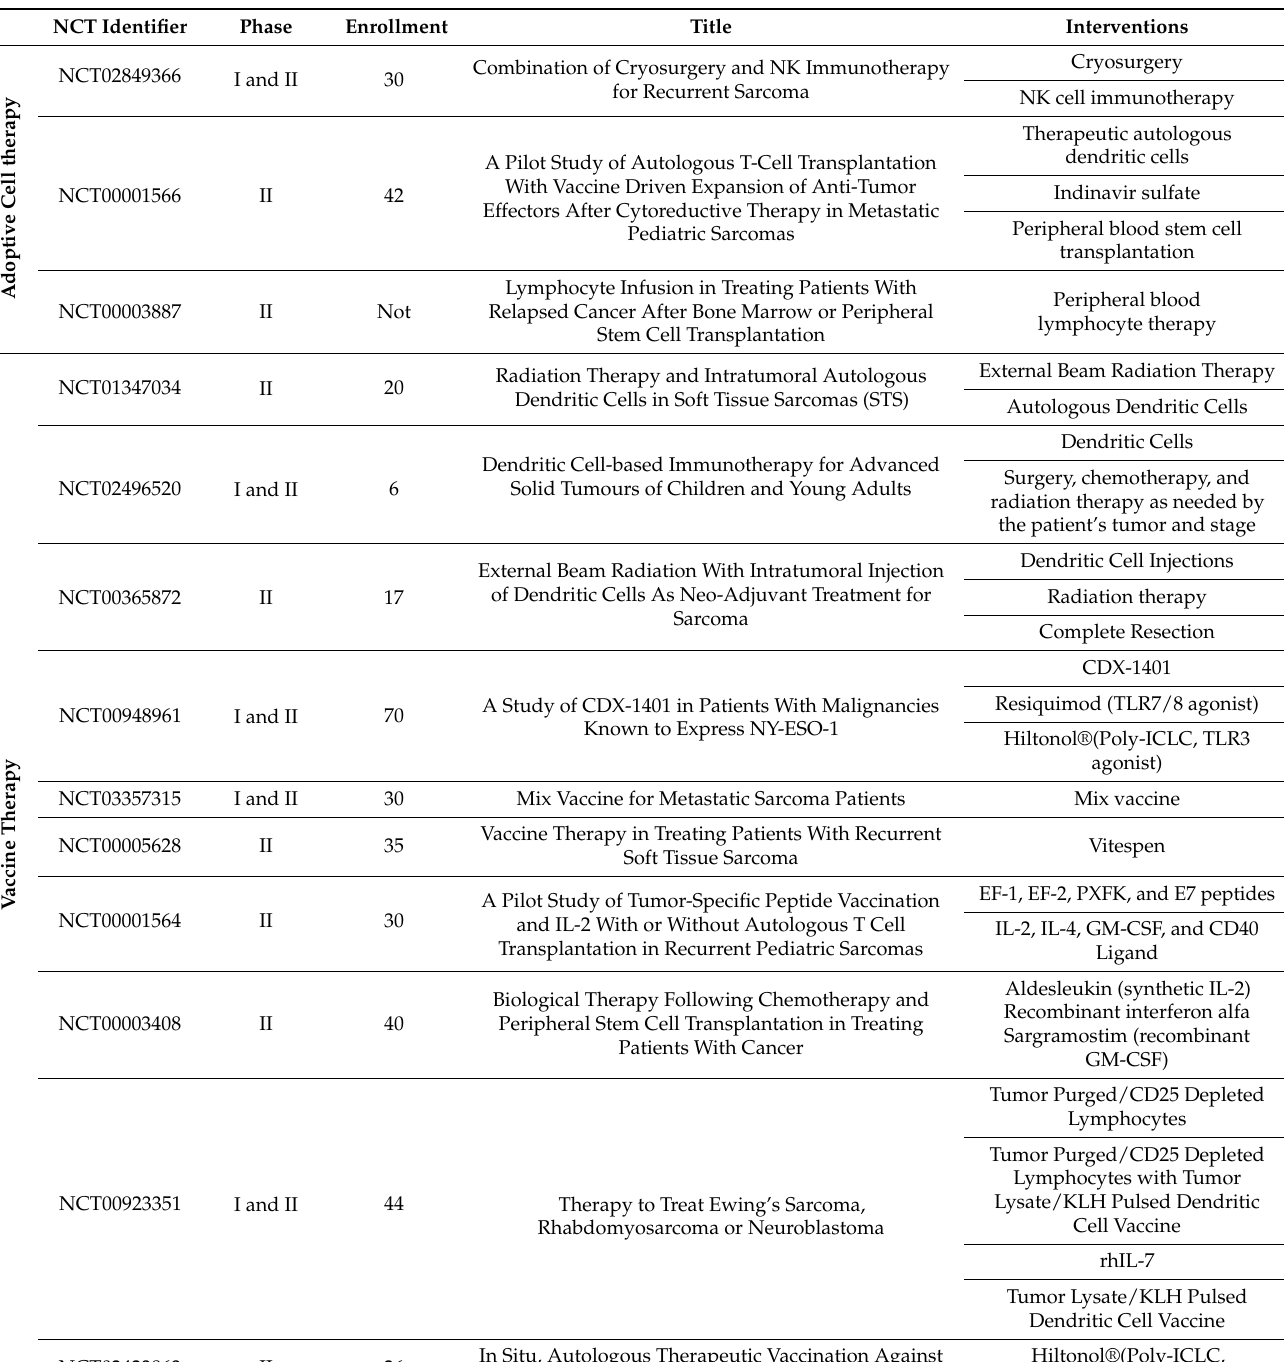
Table 1. Completed phase II and III clinical trials for immunotherapy in soft tissue